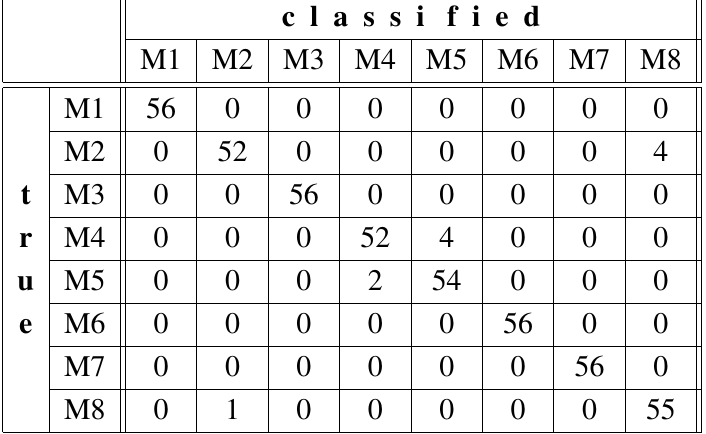
Table 9. Confusion matrix for the k -NN algorithm for k = 1 (LOO cross validation, 97.6%).